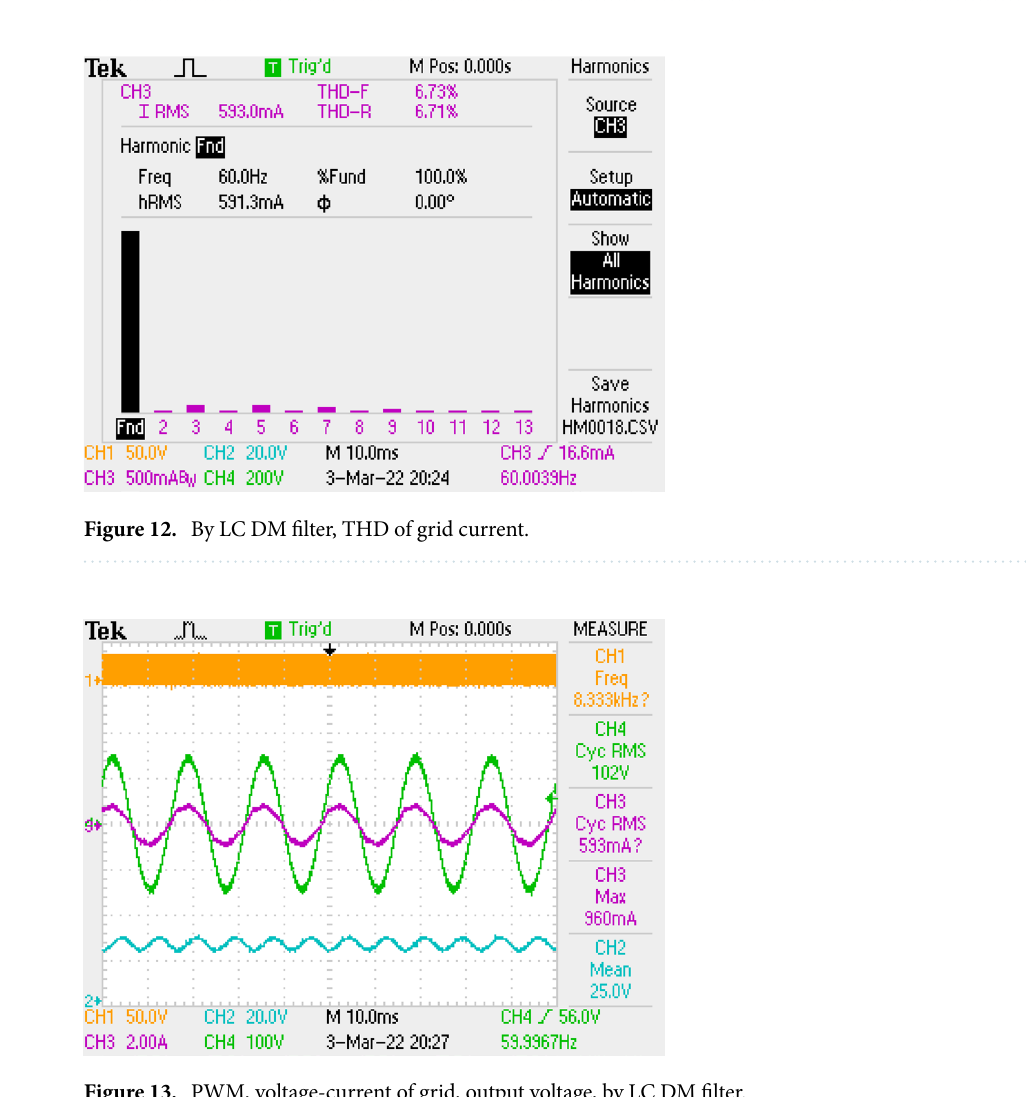
Figure 13. PWM, voltage-current of grid, output voltage, by LC DM